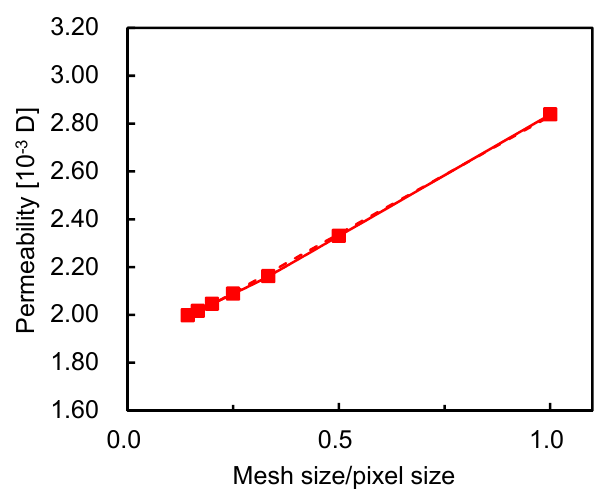
Figure 6. Linear dependence of calculated permeability on mesh size for CQ-N100-R1.